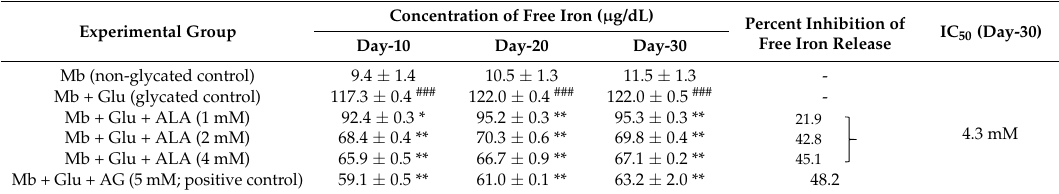
Table 1. Effect of α -lipoic acid on free iron release in glucose-induced myoglobin glycation. Concentration of Free Iron ( µ g/dL) Experimental Group